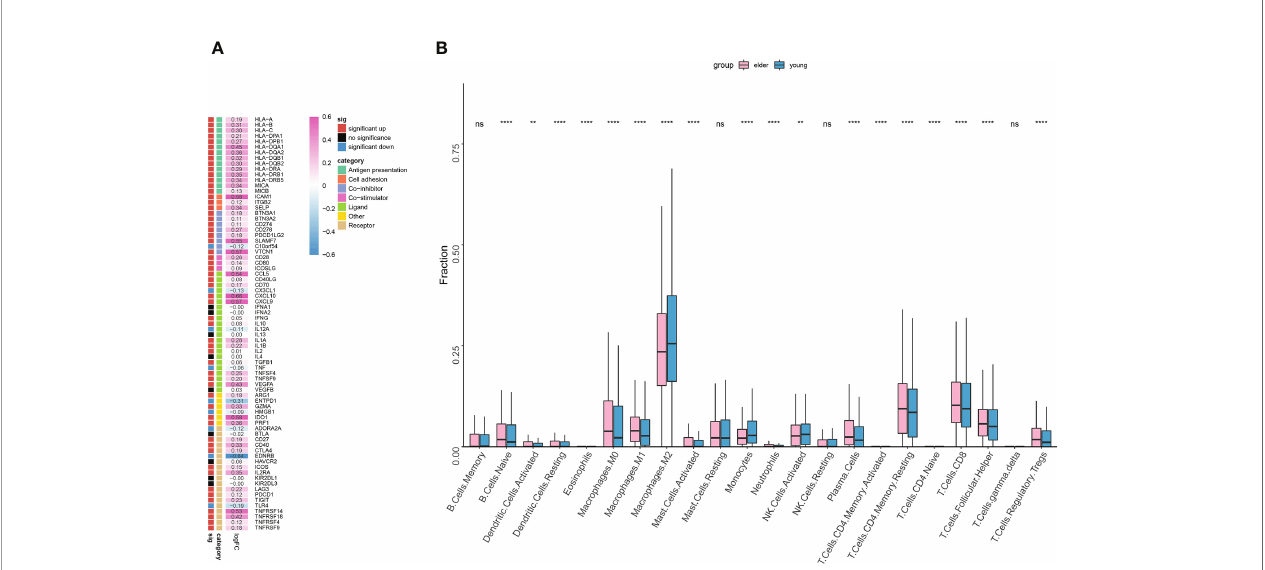
FIGURE 5 | (A) The expression of immune-related genes in the elderly group ( ≥ 50 years old) compared with the young group. Statistical signi fi cance and categories of immune-related genes are shown in the bar on the right. (B) Differences in the in fi ltration scores of 22 immune cell types between the older ( ≥ 50 years old) and younger groups. ns, no signi fi cant difference. **P < 0.01, ****P <